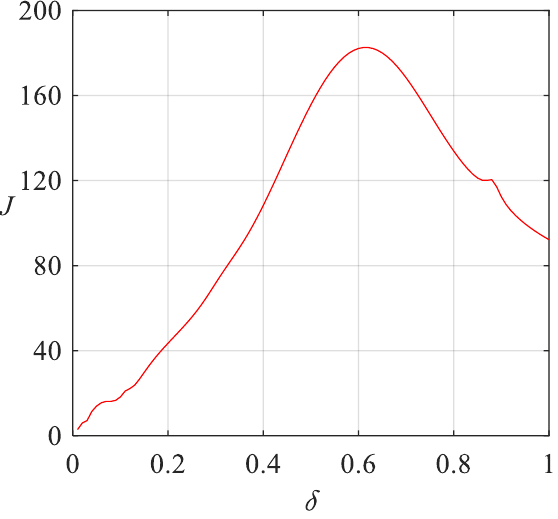
Figure 10. Parameter selection results of Gaussian kernel of EEMD-NKJADE method.